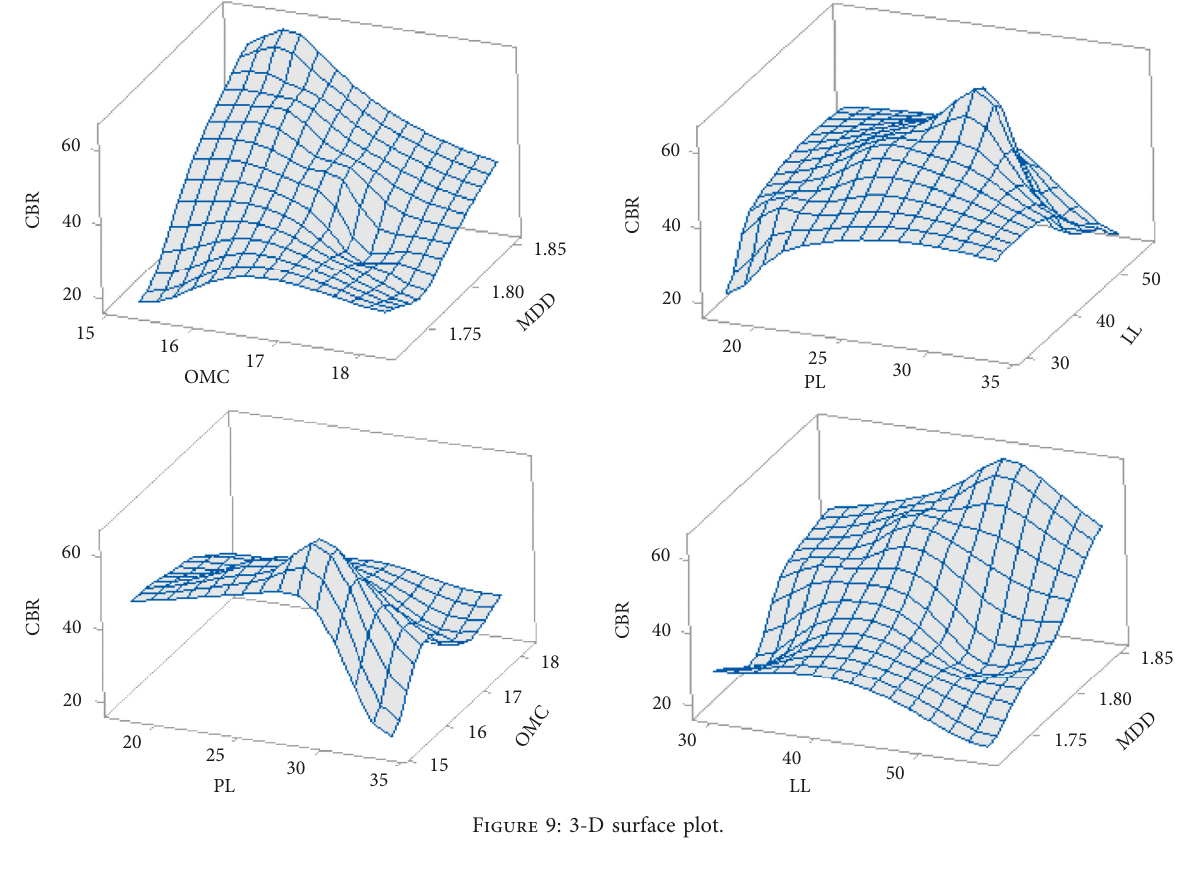
Figure 9: 3-D surface plot.